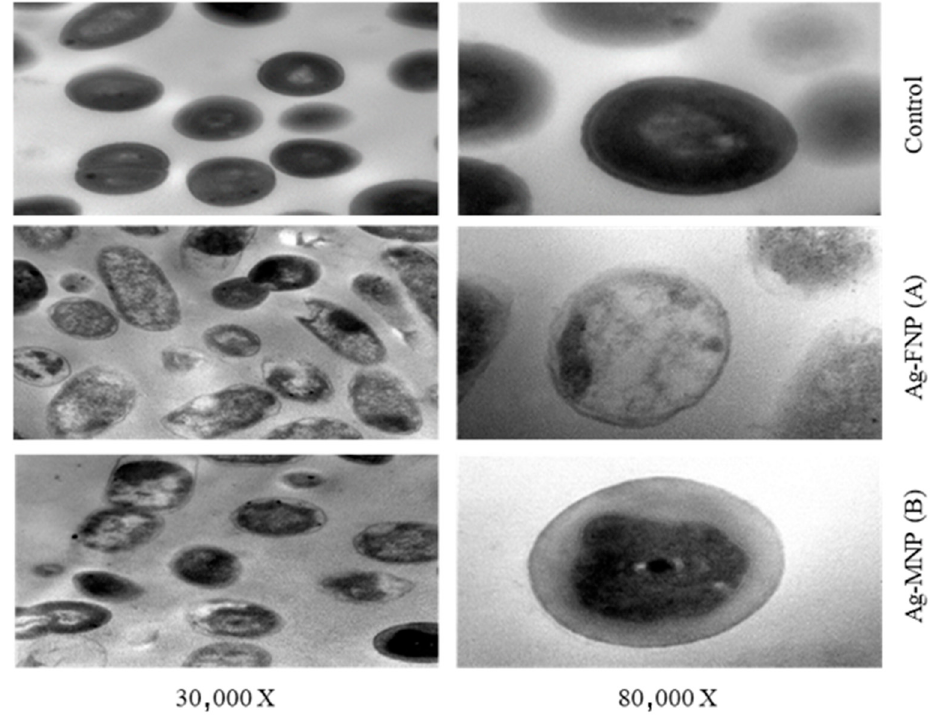
Figure 8. TEMs of S. aureus as affected by MIC of ( A ) Ag-MNP and ( B ) Ag-FNP at (30,000×, 80,000×). The MIC of Ag-FNP and Ag-MNP against S. aureus was 20 µg/mL.